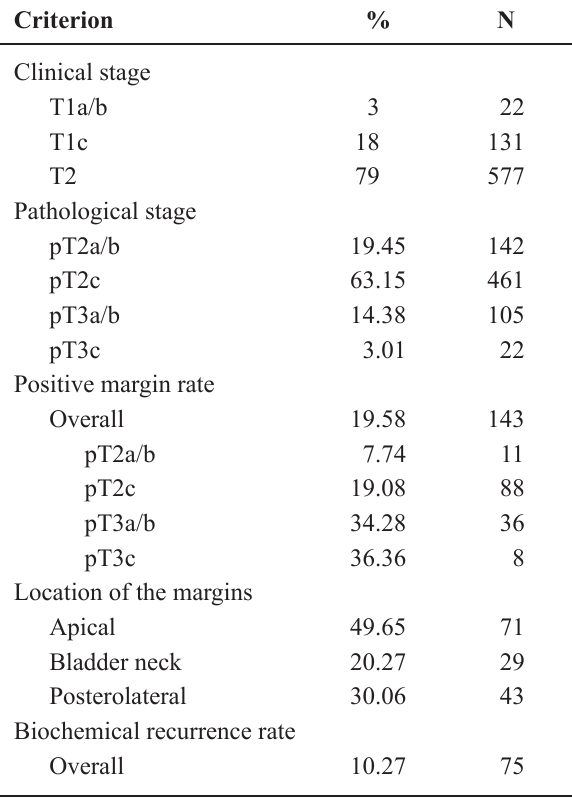
Table 3 – Oncologic results of the present